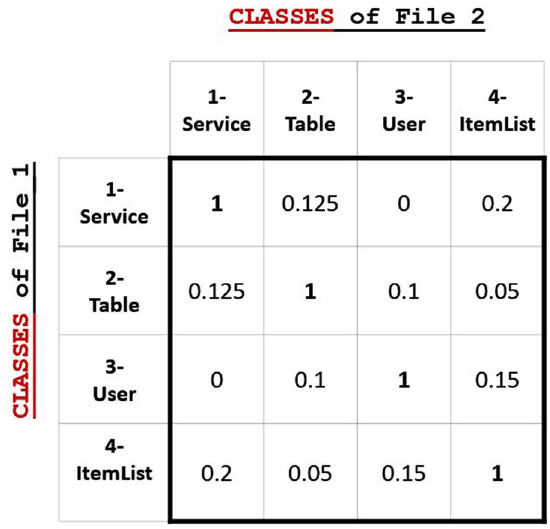
Fig. 2 A lexical per-class similarity matrix of two verbatim-copy files